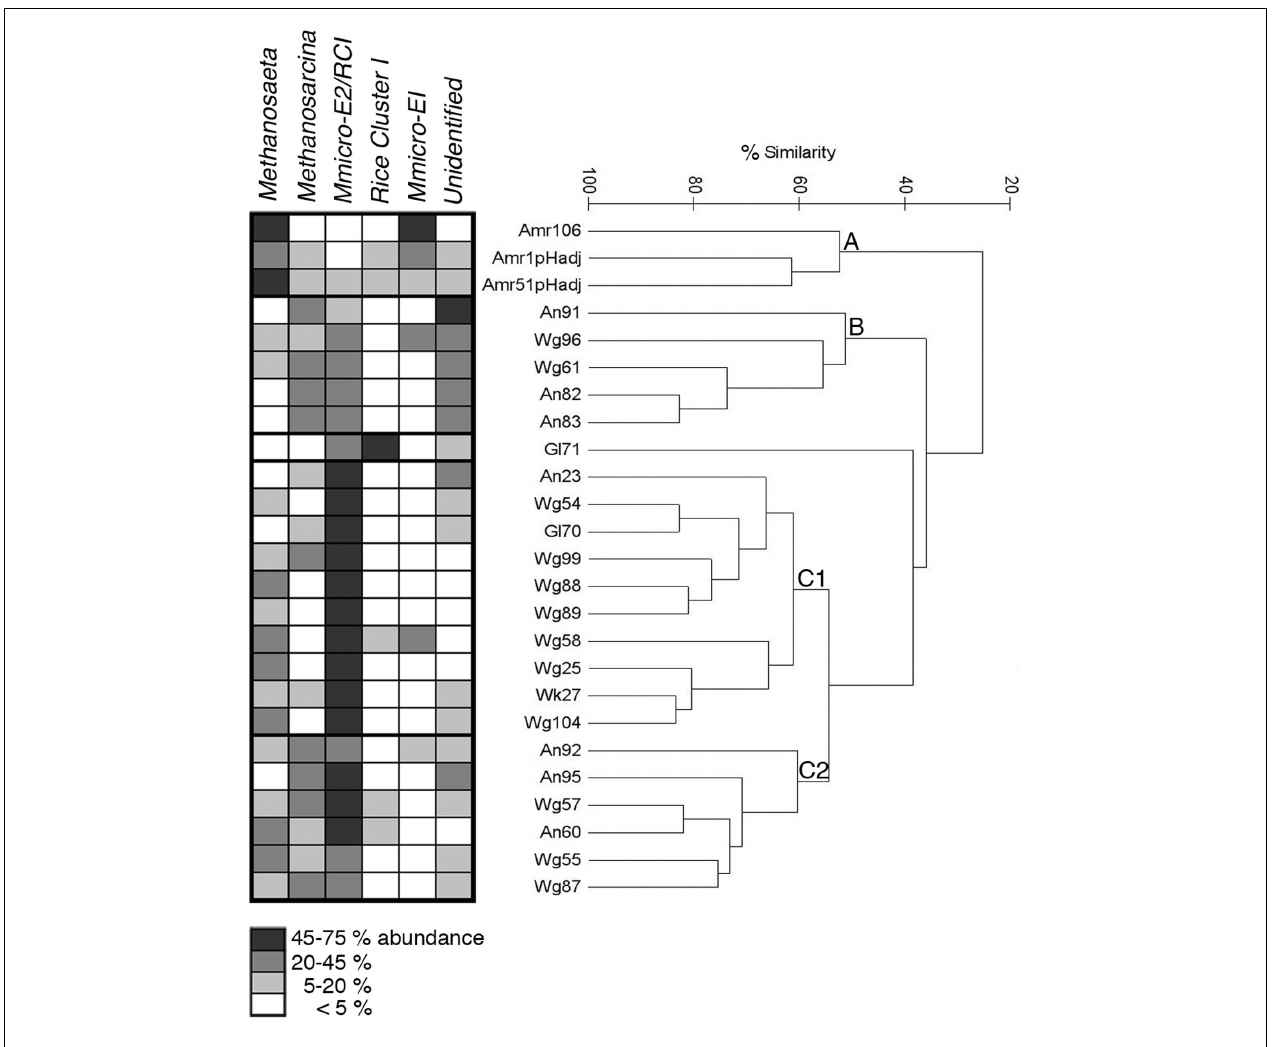
Methanocellales (RCI) specifically. Hierarchical analysis revealed three main clusters of samples (A–C), with regard to diversity and relative ratios of associated methanogens, shown at left, shaded in relation to % abundance (performed using Primer v6, Bray-Curtis similarity resemblance, Euclidean distance, and no transformation of the data). “M-micro-E2” or “E1” = Methanomicrobiales /Fen Cluster group E2 or E1,